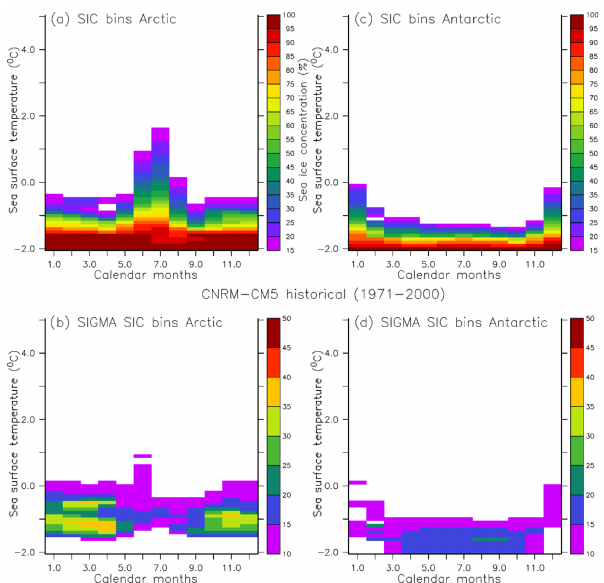
Figure B1. Look-up tables linking SST and SIC for the Arctic (a) and the Antarctic (c) built using 1971–2000 CNRM-CM5 historical simulation data and the associated uncertainty (root mean square error) in the computed SIC average (b, d) .